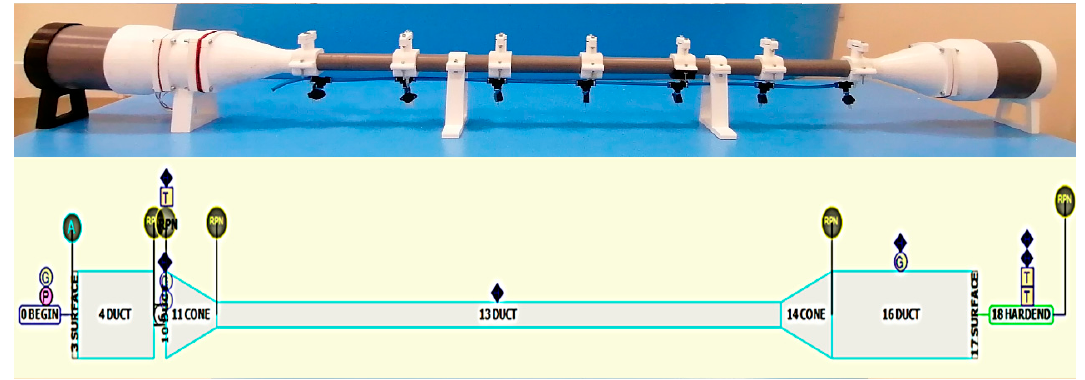
Figure 1. Acoustic test bench design. Above is a photograph of the acoustic bench built based on the DeltaEC model, the scheme of which is illustrated below.